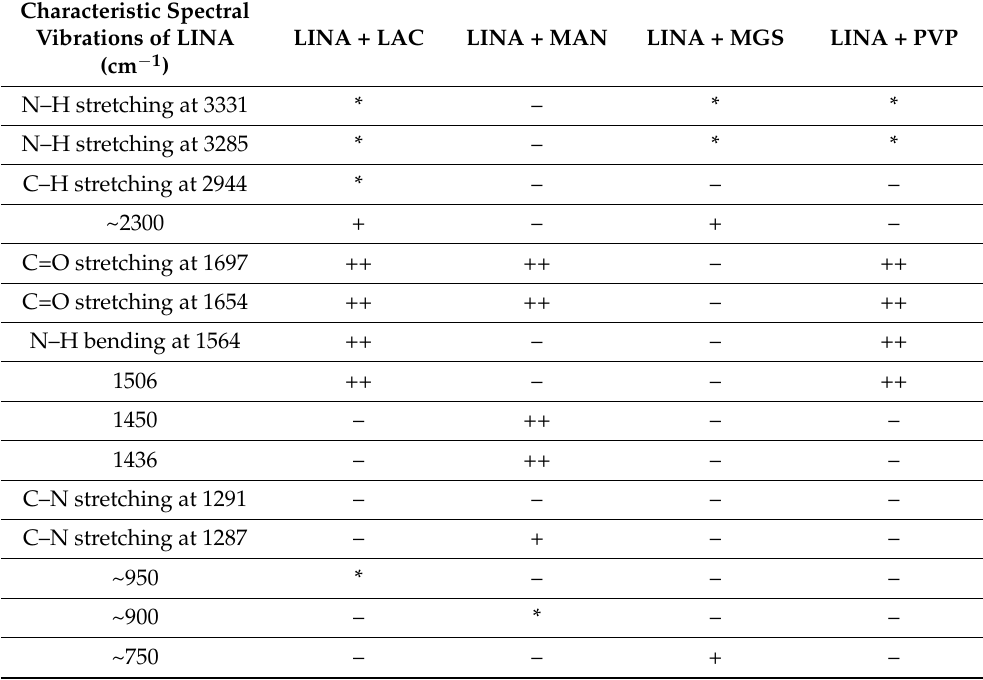
Figure 13. The first and second principal components (PC1 and PC2) calculated using matrices con- taining the FT-IR data set for: ( A ) linagliptin and lactose under non-stressed conditions, ( B ) linagliptin and its mixture with lactose under non-stressed conditions, ( C ) linagliptin and lactose under stressed conditions, and ( D ) linagliptin and its mixture with lactose under stressed conditions. Table 3. Effect of excipients and stress conditions on linagliptin based on the PC1 and PC2 values calculated using FT-IR